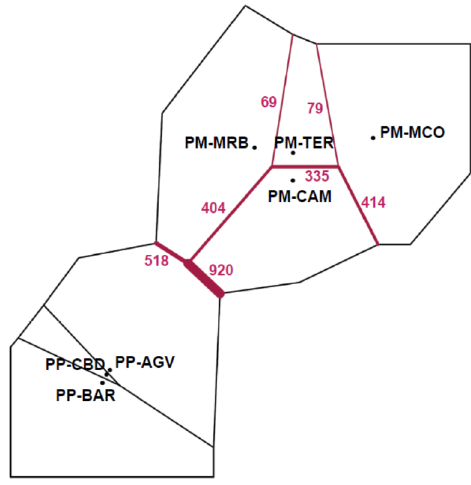
Figure 3. Analysis with Barrier v.2.2, with the first barrier checked. Significance was tested by 1000 bootstrap matrices of [27] genetic distance ( D A ). Numbers indicate bootstrap support. Codes PM-CAM, PM-MCO, PM-MRB and PM-TER are of populations of P. montsicciana , and codes PP-AGV, PP-BAR and PP-CBD of P. pardoi (see Figure 1).